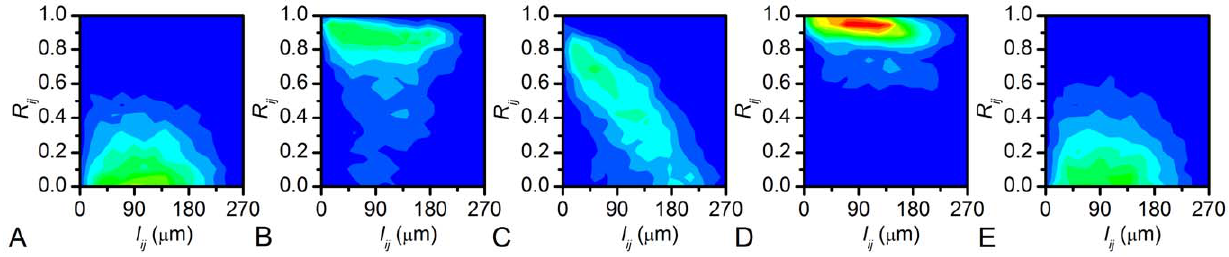
Figure 3. 2D histograms showing the distribution of pairs of cells with regard to their Euclidean distance l ij and correlation coefficient R ij . From left to right, histograms illustrating the distribution in low glucose before stimulation (A), during activation (B), during sustained activity in high glucose (C), during deactivation (D), and in low glucose after stimulation (E) are presented. The color profile is linear and the same in all panels. Blue depicts 0 and red 520 pairs of connected cells in a given interval.